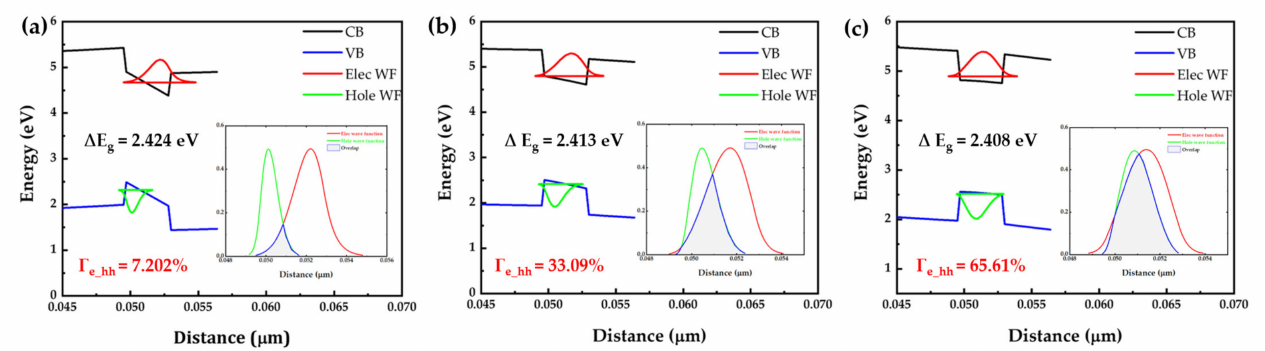
Figure 1. The simulated band diagram and wavefunction overlap of ( a ) c-plane (0001), ( b ) semipolar (2021), and ( c ) m-plane (1010) micro-LED at 100 mA. (CB: Conduction band; VB: Valence band; Elec WF: Electron wavefunction; Hole WF: Hole wavefunction; ∆ E g : Bandgap; Γ e _ hh : The envelope electron and hole wavefunction